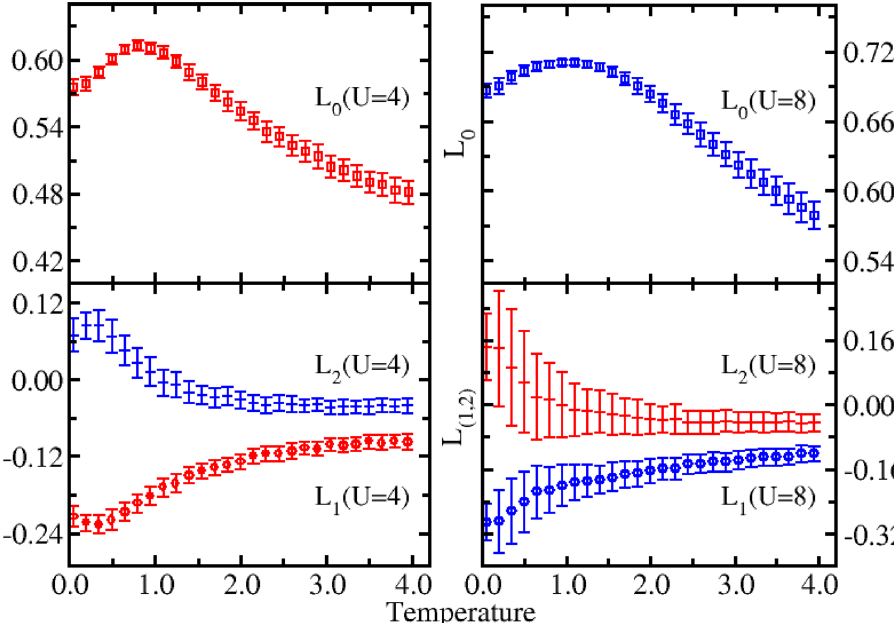
Figure 6. Local moment ( L α 0 ) and spin correlation functions ( L α 1,2 ) as a function of temperature for U = 4 = = (left panel) and U = 8 (right panel) of the system with six lattice sites. L 0 , L 1 , and L 2 represent the local magnetic moment, the nearest-neighbor spin correlation, and the next-nearest-neighbor spin correlation,